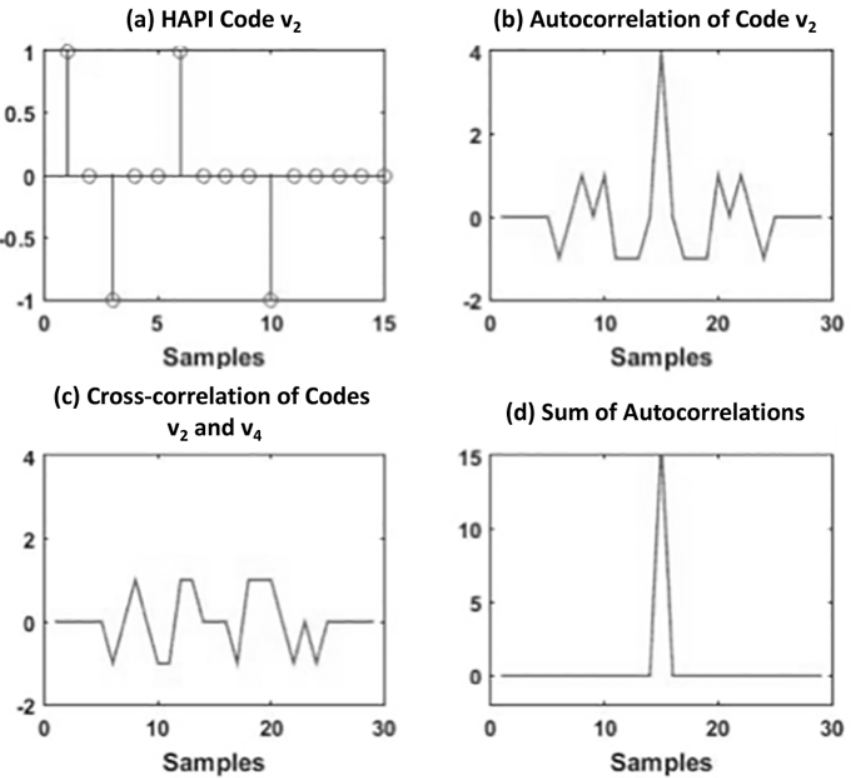
Figure 2. ( a ) Temporal representation of code v 2 , ( b ) autocorrelation of code v 2 , ( c ) cross-correlation of codes v 2 and v 4 , and ( d ) sum of all the autocorrelations of codes v 1 through v 4 .